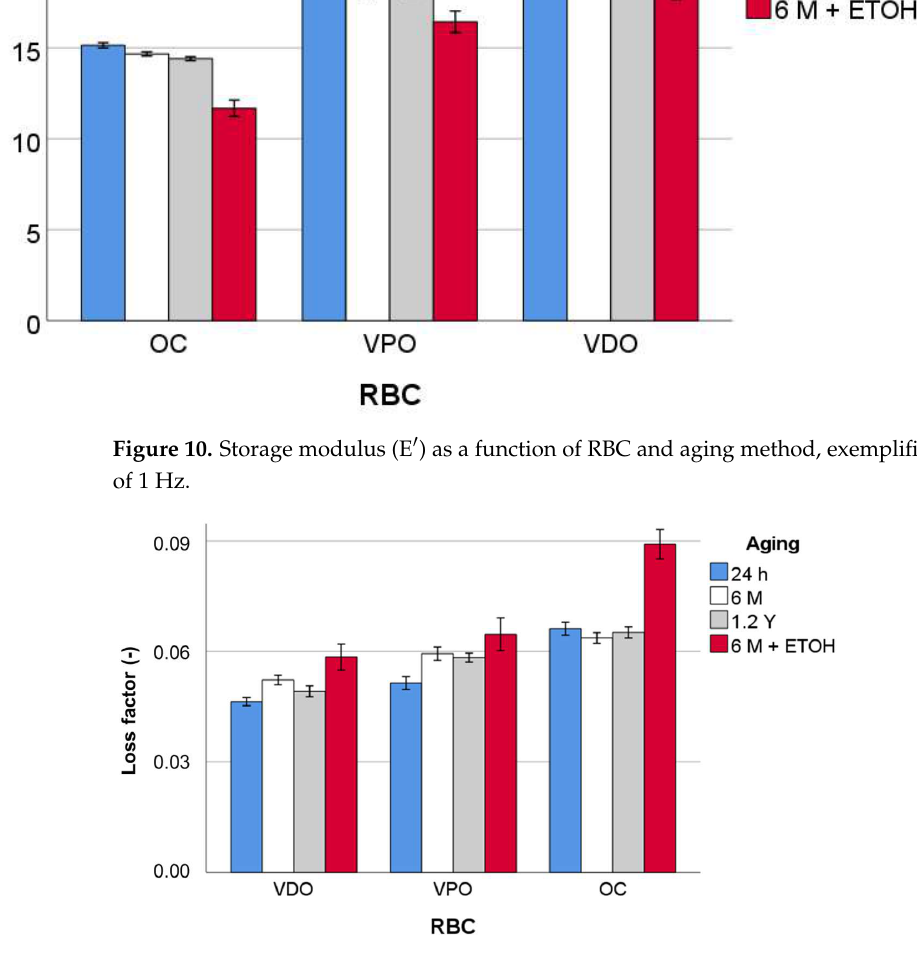
Figure 11. Loss factor (tan δ ) as a function of RBC and aging method, exemplified for a frequency of 1 Hz.